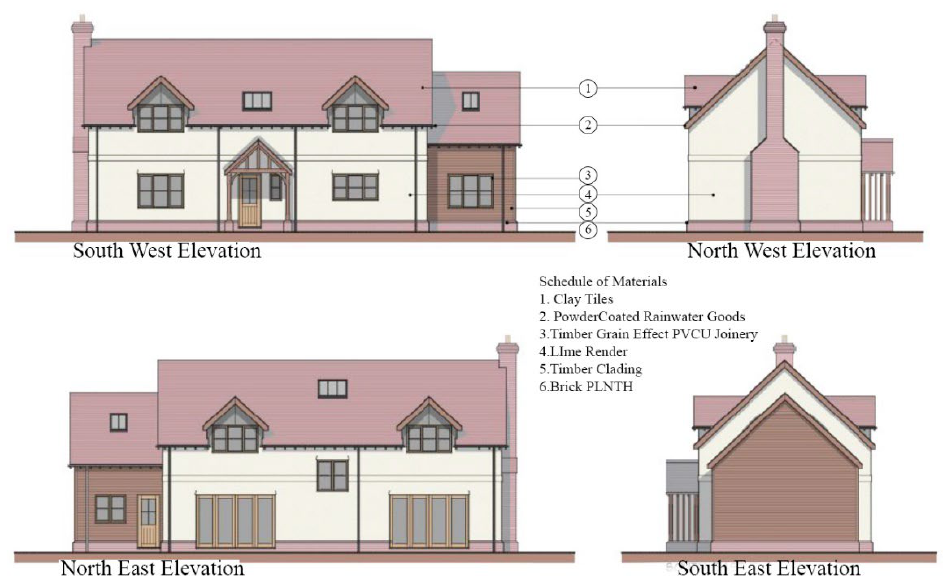
Figure 2. The dwelling selected in this study to conduct the comparison between timber frame and masonry. Table 1. Build cost and time comparison between timber frame and masonry.